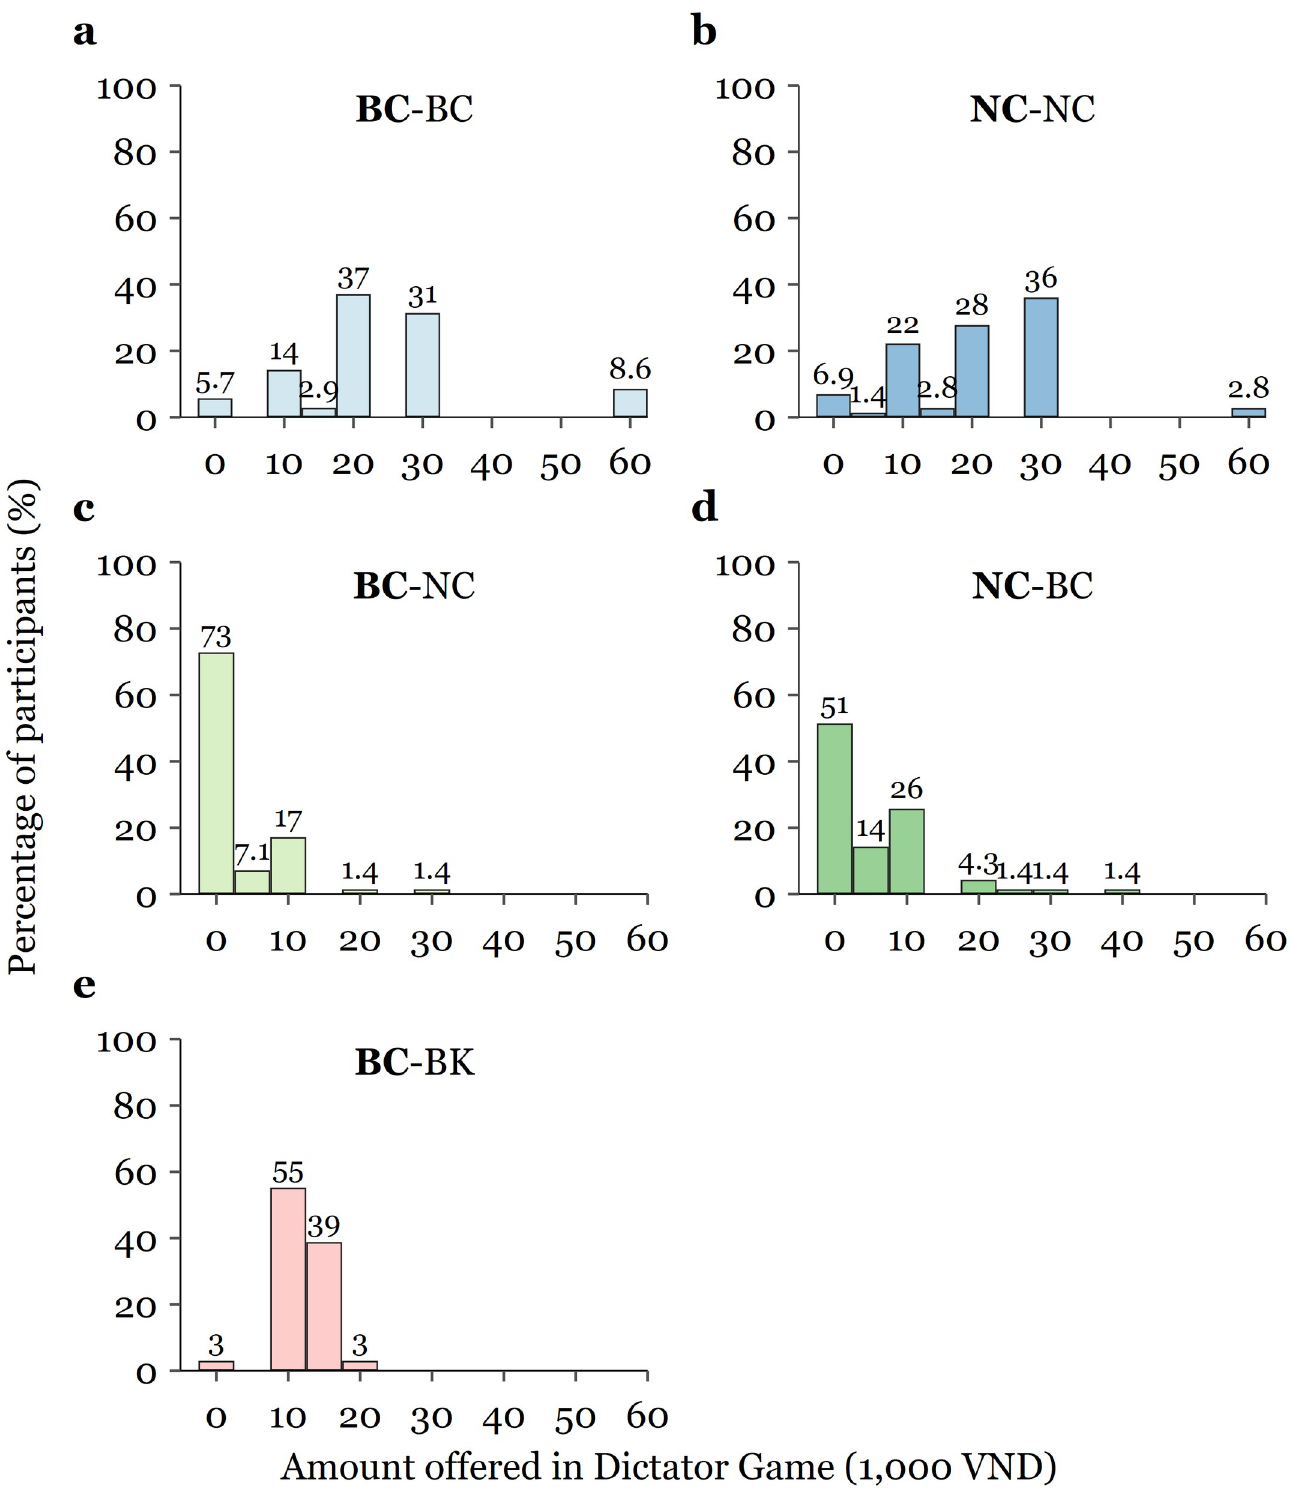
Fig 2. Distribution of amount offered in Dictator Game, by treatment and session. Bin width of VND 5,000. Panels a and b: PURE IN-GROUP treatment; Panels c and d: IN-GROUP STRANGER treatment; Panel e: OUT-GROUP: treatment. Sender (Player 1) in bold.